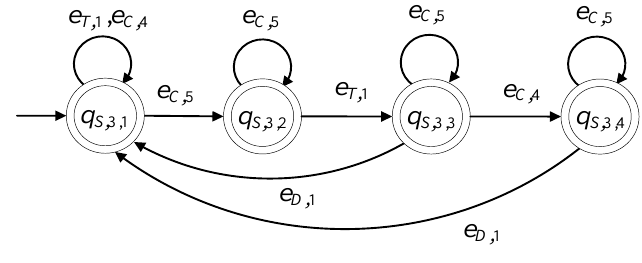
Figure 10. State diagram of S 3